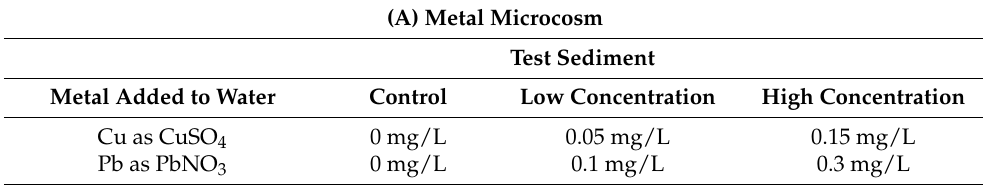
Table 2. Metal and nutrient microcosm experiment design with sediment treatment type for each wetland (1, 2, 3, and 4) in control and test sediments.